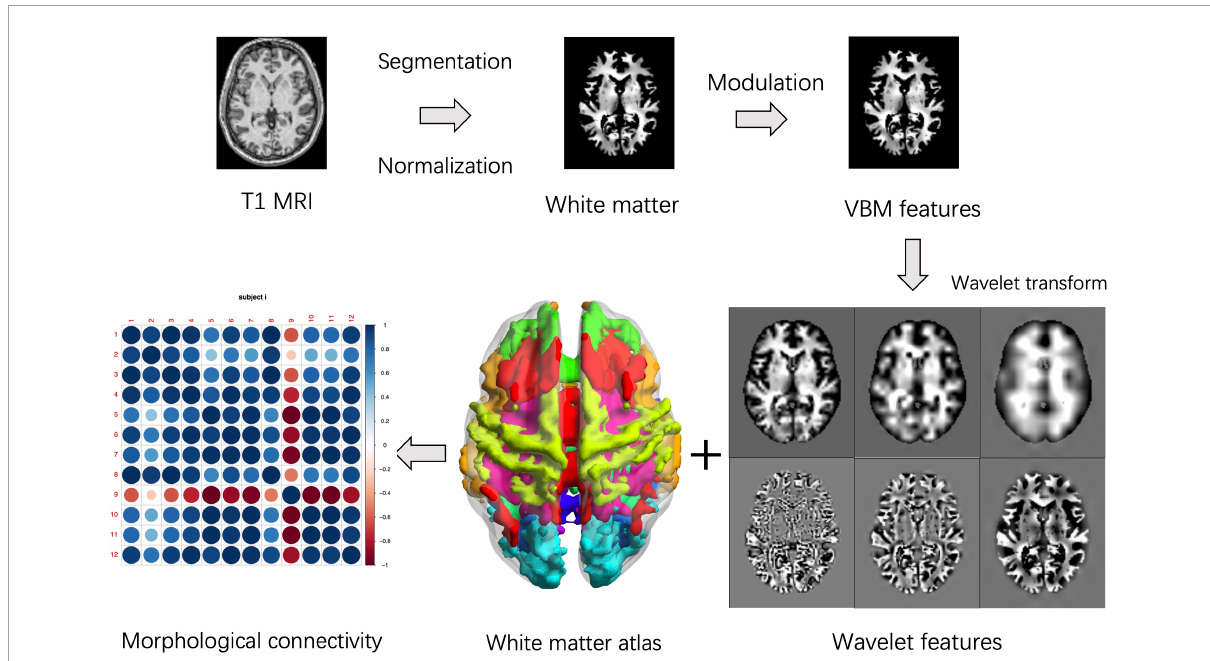
FIGURE1 Pipelines for white matter structural covariance connectivity extraction. For each subject, the voxel-based morphology (VBM) transform is performed on the spatially normalized and modulated T-1 weighted white matter images. Then, 3D wavelet transform is performed on the individual VBM volume. Third, the white matter is assigned to 12 white matter networks (WMNs). Finally, the white matter structural covariance connectivity is computed based on correlation coefficients of the regional wavelet features. The VBM features, wavelets features and network features are significantly different from one of our previous study (Wang et al.,